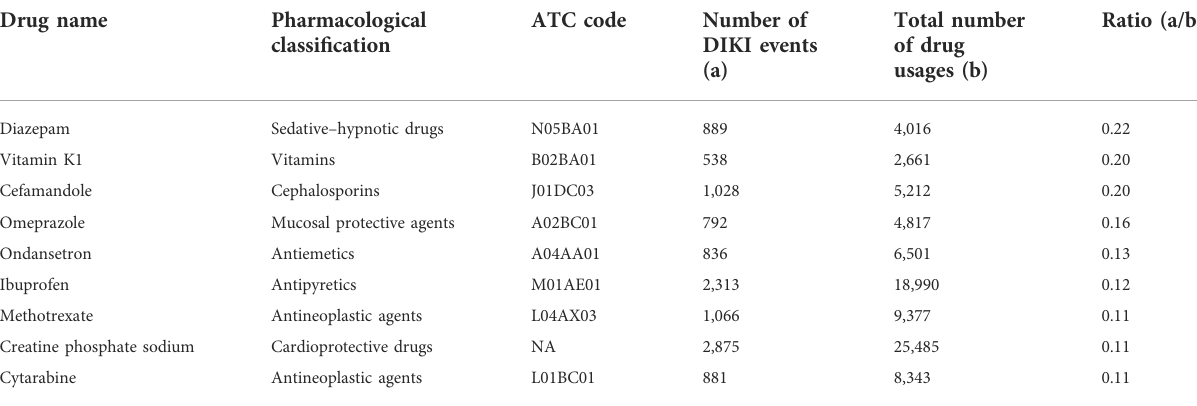
TABLE 1 Suspected drugs related to DIKI in pediatrics in stage